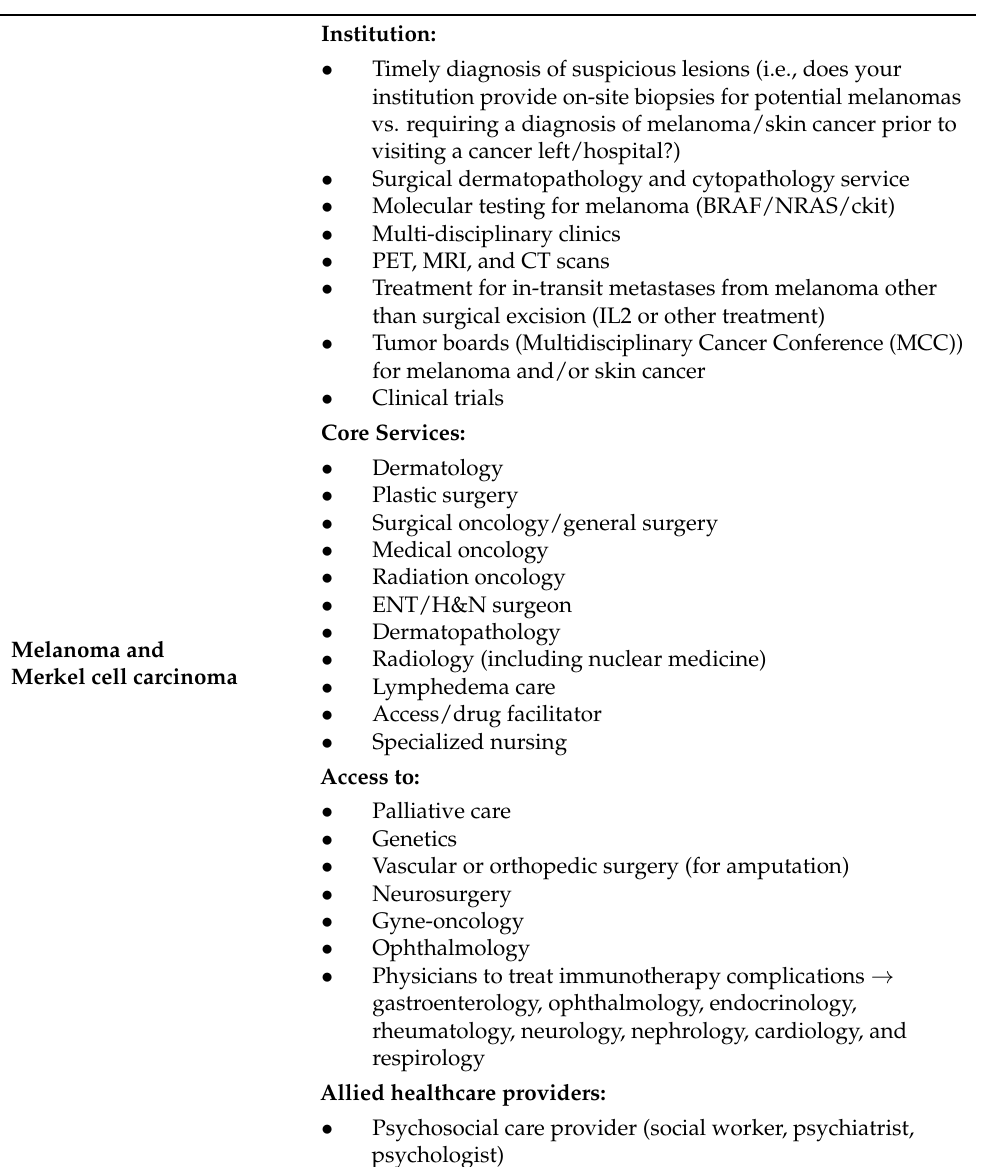
Table 2. Clinical services that are required for the management of complex skin